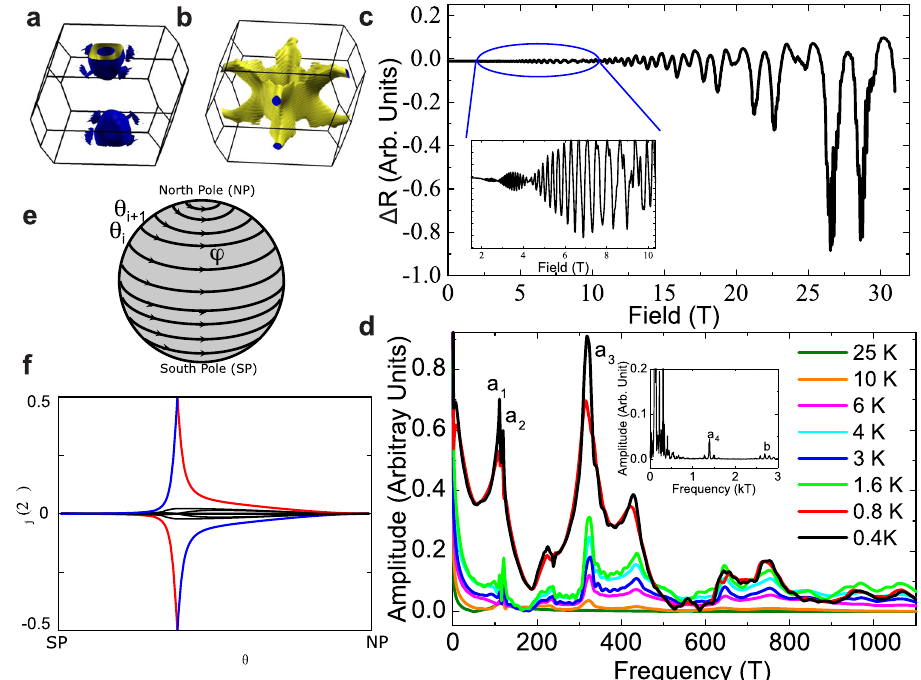
Fig. 5 Fermi surface and quantum oscillation of Dirac semimetal BaAl 4 . a , b Calculated hole pockets ( a ) and electron pockets ( b ) in the Fermi surface for BaAl 4 by density function theory with spin-orbit coupling. c The quantum oscillation in the magnetoresistance of BaAl 4 single crystal at 2 K. The inset shows the FFT spectrum of the quantum oscillation. d Enlarged part of the low frequency region of the FFT spectrum of the quantum oscillation for Sample B of BaAl 4 at different temperatures. The inset shows the detail of the FFT spectrum in high frequency region at 2K. e Wilson loop spectrum on a spherical surface enclosing the Dirac point ð 0 ; 0 ; k c z Þ . f Phase φ j of the individual loop eigenvalues ð e i φ j Þ as a function of the azimuthal angle θ